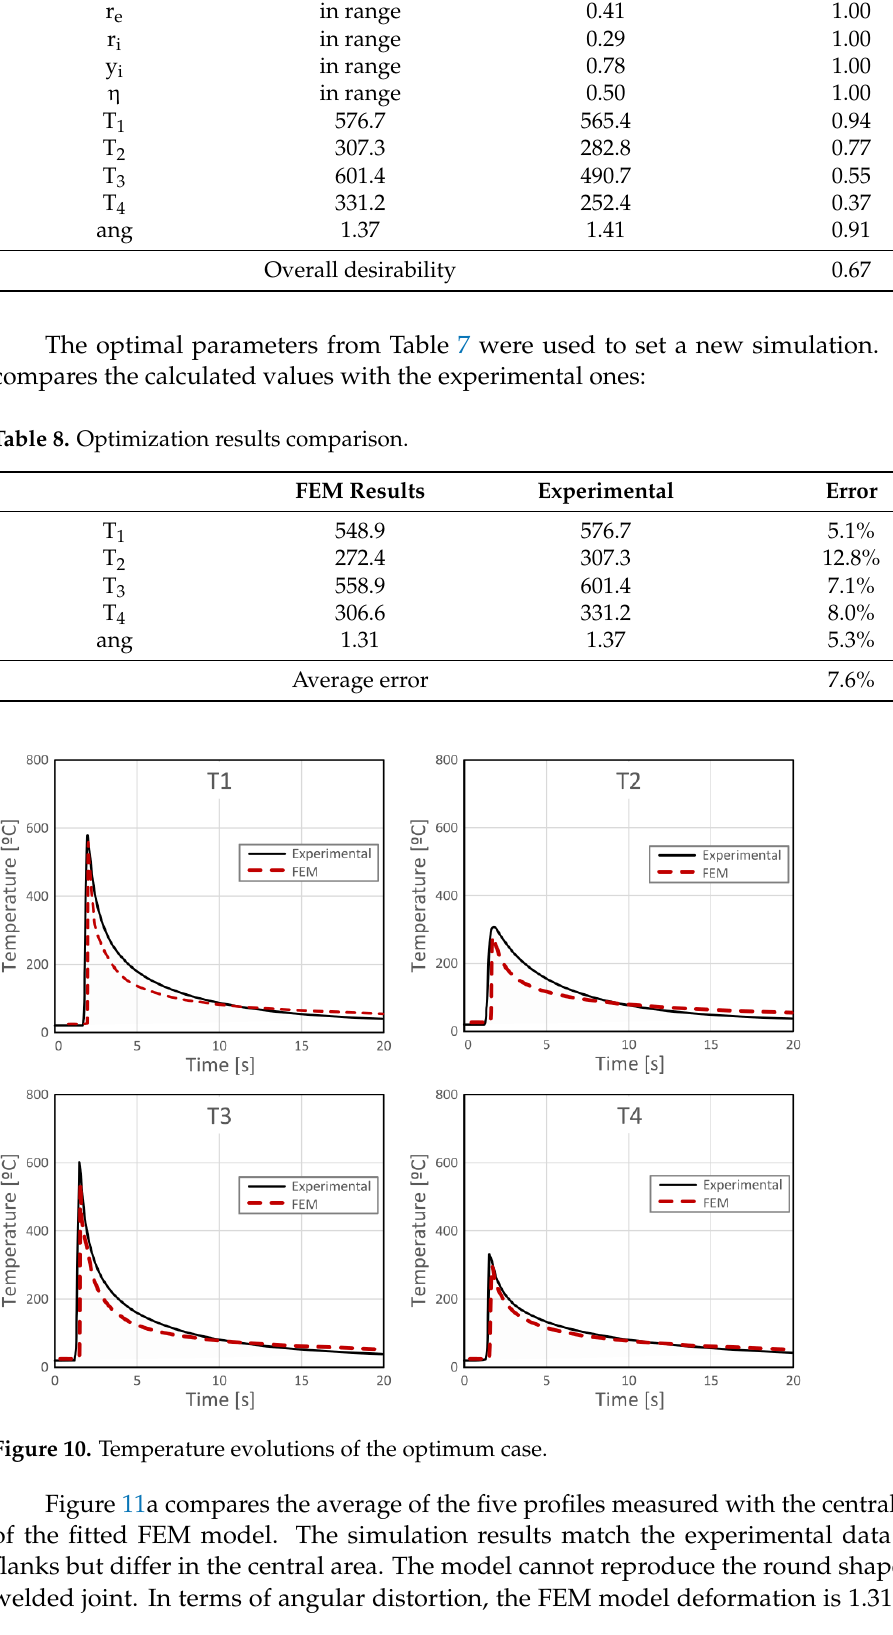
Table 7. Optimization objectives, results, and desirability.